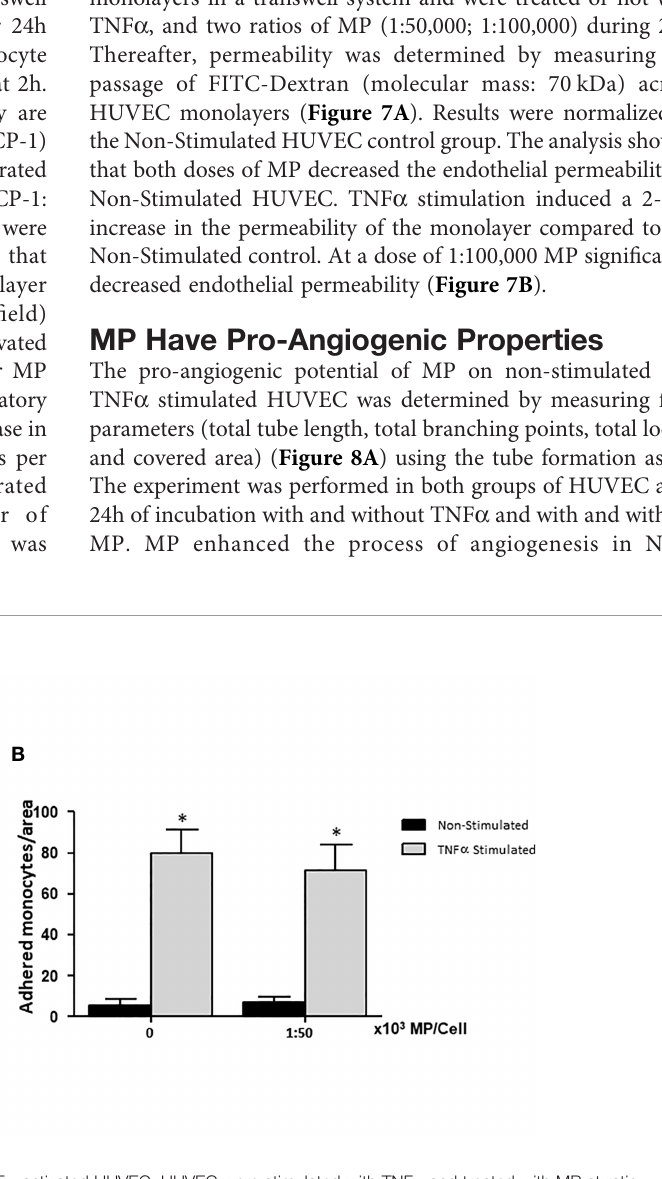
FIGURE 5 | Effects of Membrane Particles on monocyte adhesion to TNF a -activated HUVEC. HUVEC were stimulated with TNF a and treated with MP at ratio 1:50,000. Subsequently, CFSE-labeled monocytes were added during 1h. (A) Representative fl uorescent microscopy pictures show the adhered monocytes (white dots) to the HUVEC monolayer in non-stimulated and TNF a stimulated conditions. (B) Quantitative results of the monocyte adhesion assay analyzed by imageJ. No signi fi cance difference respect to the respective control (Non-Stimulated, and TNF a Stimulated HUVEC) was observed when MP were added *p < 0.05 compared to Non-Stimulated